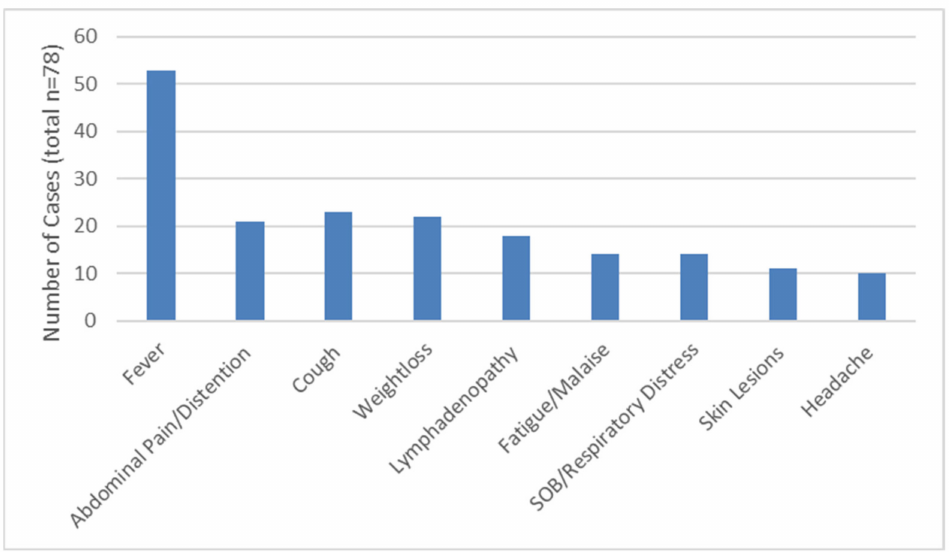
Figure 2. The most commonly presented features of the 78 children with